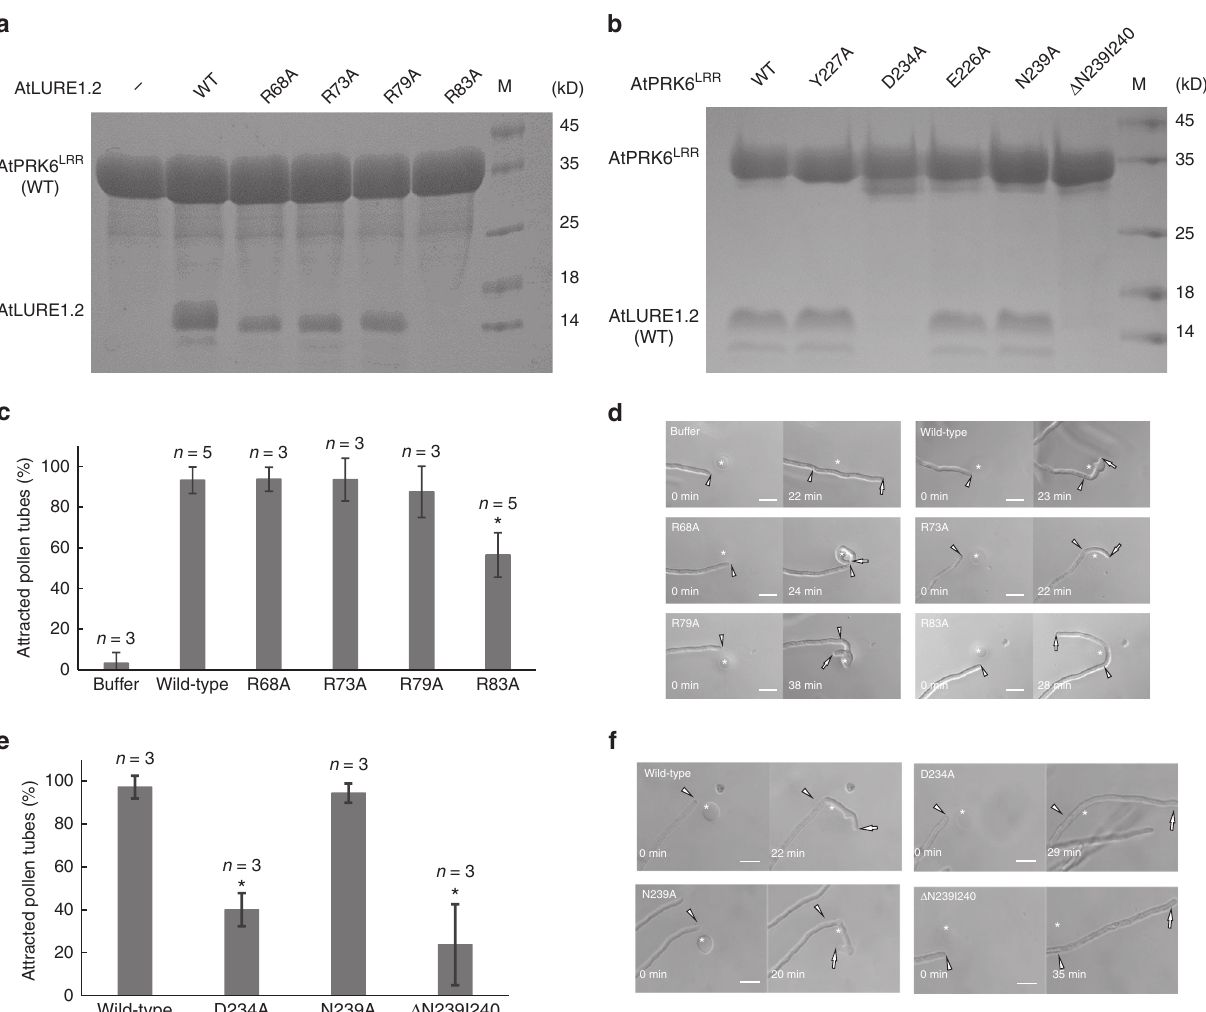
Fig. 4 Mutagenesis analysis and pollen tube attraction with mutant AtLURE1.2 and AtPRK6. a Effect of AtLURE1.2 mutations on the interaction with AtPRK6 LRR . The assay was performed as described in Fig. 1a. b Effect of AtPRK6 LRR mutations on the interaction with AtLURE1.2. The assay was performed as described in Fig. 1a. c Attraction frequencies of pollen tubes by mutant AtLURE1 peptides. Attraction frequencies of semi-in-vivo pollen tubes were examined using gelatin beads containing 250 nM AtLURE1.2 peptides of wild-type and mutants, respectively. For each assay, 9 – 16 pollen tubes were examined, and assays were repeated 3 − 5 times in each condition. Data are mean and s.d., and numbers of assays (replicates) in each condition were indicated. An asterisk indicates statistical signi fi cance among wild-type and mutant AtLURE1.2 peptides (Tukey − Kramer test; P < 0.05). The frequency in R83A AtLURE1.2 was signi fi cantly lower than those in other four peptides. d Pollen tubes attraction in gelatin-beads assay. Photographs just after putting beads (0 min) and after attraction are shown. Arrowheads indicate the tip position when a bead was placed and arrows indicate the tip of attracted pollen tubes at the indicated time. The data are representative of 20 − 25 images. In the assay using R83A AtLURE1.2, more than 44% pollen tubes were not attracted to the bead. Scale bars are 20 μ m. e Attraction frequencies of pollen tubes with mutations in PRK6 receptor. Attraction frequencies of semi-in- vivo pollen tubes (prk6 transformed with PRK6 of wild-type, D234A, N239A, and Δ N239I240) were examined using gelatin beads containing 250 nM wild-type AtLURE1.2 peptides. For each assay, 10 – 23 pollen tubes were examined, and repeated for three times in each condition. Frequencies in D234A and Δ N239I240 PRK6 pollen tubes were signi fi cantly lower than those in wild-type and N239A PRK6 pollen tubes. f Pollen tubes attraction in gelatin- beads assay. Photographs just after putting beads (0 min) and after attraction are shown. Arrowheads indicate the tip position when a bead was placed and arrows indicate the tip of attracted pollen tubes at the indicated time. The data are representative of 11 − 14 images. Scale bars are 20 μ m